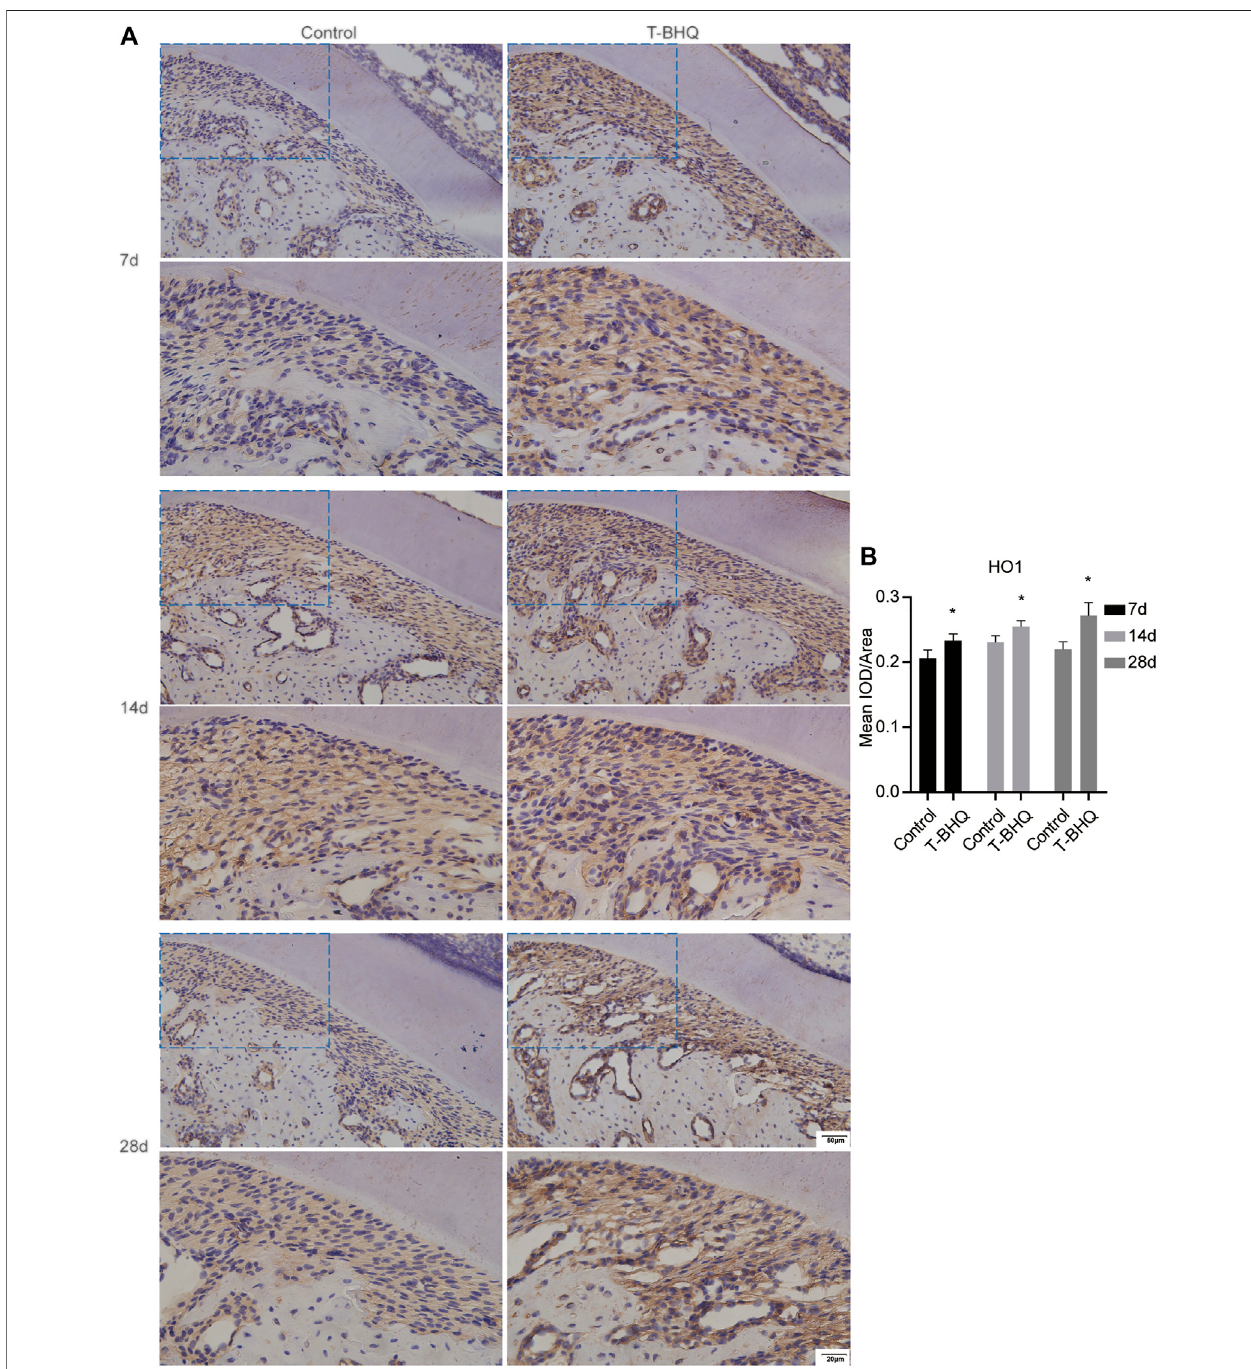
FIGURE 6 | The increased expression of HO1 in the PDL at the tension side in orthodontic rats with t-BHQ treatment. (A) T-BHQ could promote the expression level of HO1, the downstream antioxidant of Nrf2, in the PDL at the tension side in orthodontic rats through IHC staining. The scale bars, 20 and 50 µm. (B) The mean IOD/Area of HO1 was quanti fi ed through Image-Pro Plus 6.0 software. N (cid:1) 3 specimens in each group.